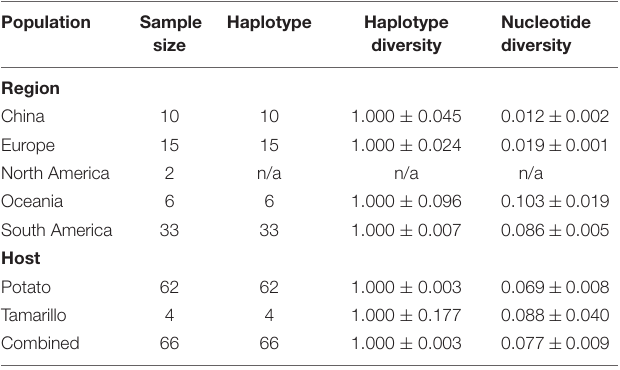
TABLE 1 | Genetic diversity parameter estimates for PVA population.